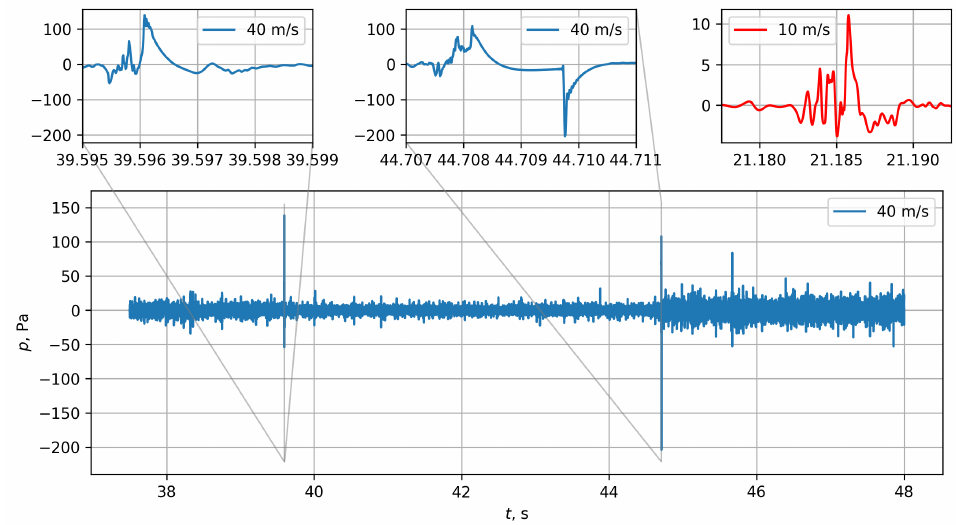
Figure 8. Time series of a chosen MEMS microphone at 40 m/s (blue) with zoomed-in sub-figures of peculiar events. For comparison, a zoomed-in result is shown at 10 m/s